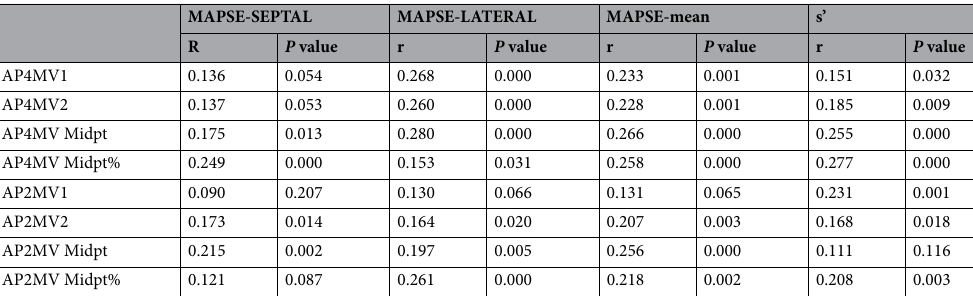
Table 5. Correlation analysis of TMAD parameters with MAPSE parameters and s’. TMAD, tissue mitral annular displacement; AP4MV1, displacement of the septal annulus toward the apex; AP4MV2, displacement of the lateral annulus toward the apex; AP4MV Midpt, displacement of a midpoint in a four-chamber view toward the apex; AP4MV Midpt%, proportional displacement of a midpoint in a four-chamber view toward the apex (AP4MV Midpt/left ventricular end-diastolic internal diameter); AP2MV1, displacement of the anterior annulus toward the apex; AP2MV2, displacement of the inferior annulus toward the apex; AP2MV Midpt, displacement of a midpoint in a two-chamber view toward the apex; AP2MV Midpt%, proportional displacement of a midpoint in a two-chamber view toward the apex (AP2MV Midpt/left ventricular end- diastolic internal diameter). MAPSE, Mitral Annular Plane Systolic Excursion.